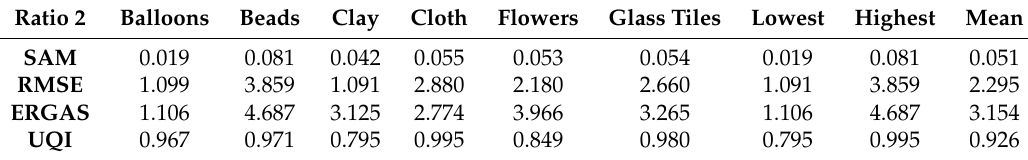
Table 1. Spectral quality indexes for the higher spatial resolution CAVE images trained with input of 256 × 256 pixels.